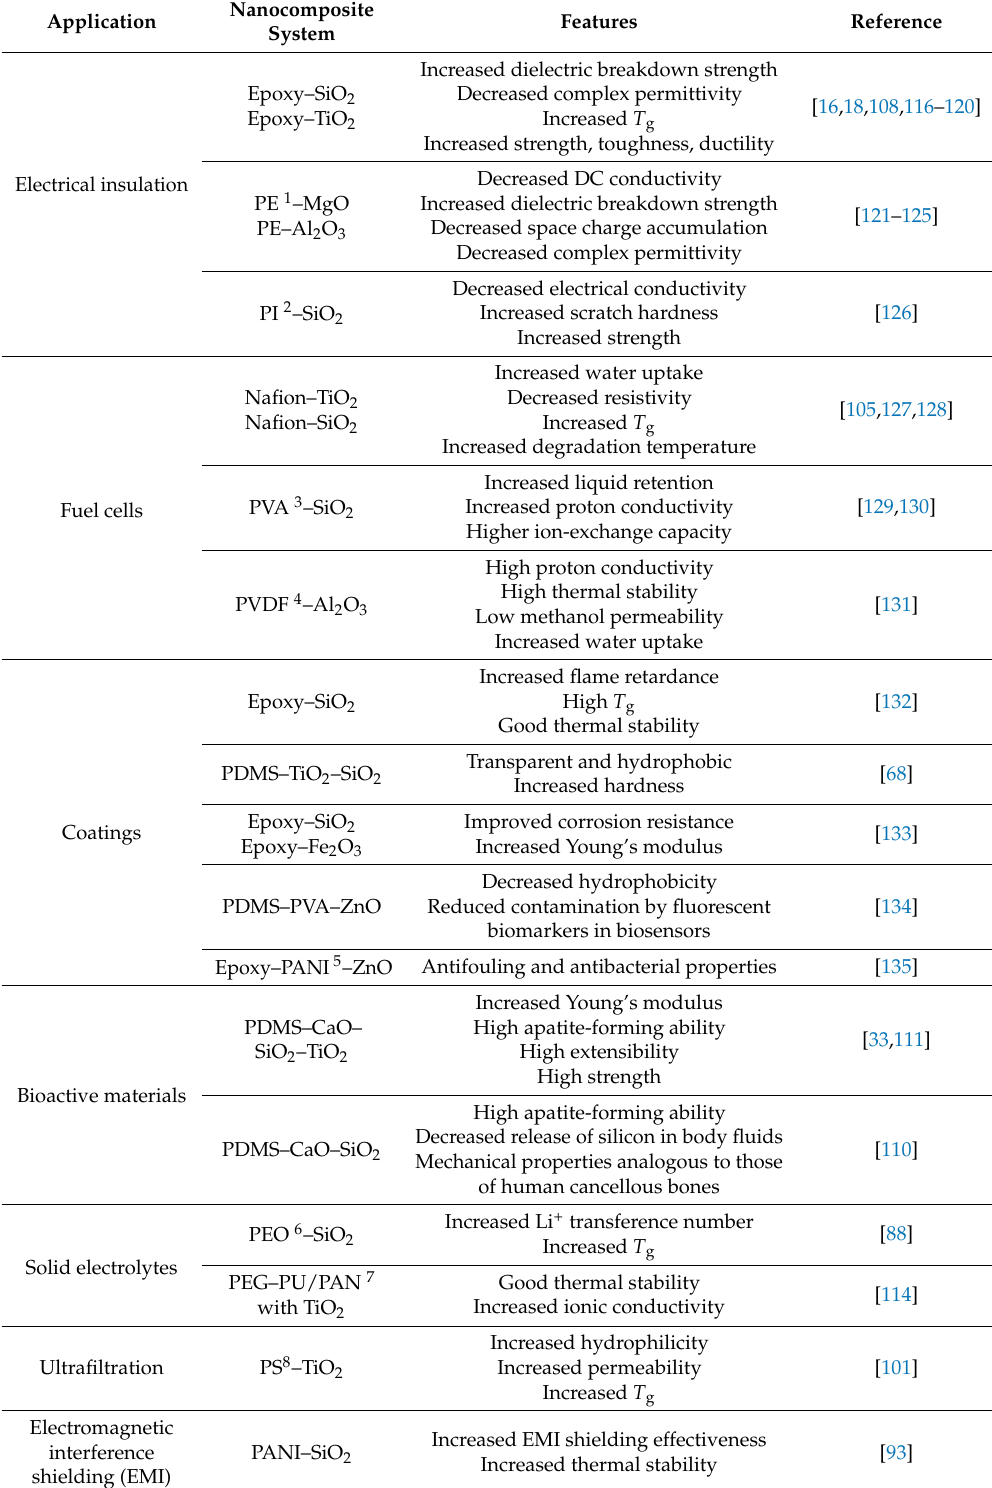
Table 3. Selected examples of applications and relevant features for several polymer–inorganic oxide